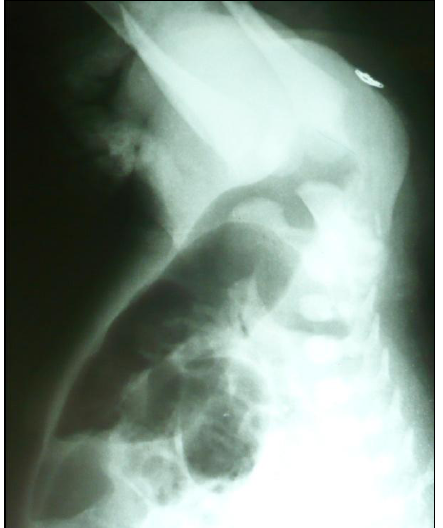
Figure 1: High variety Imperforate anus. A 36-hour-old male neonate presented with imperforate anus and abdominal distension.